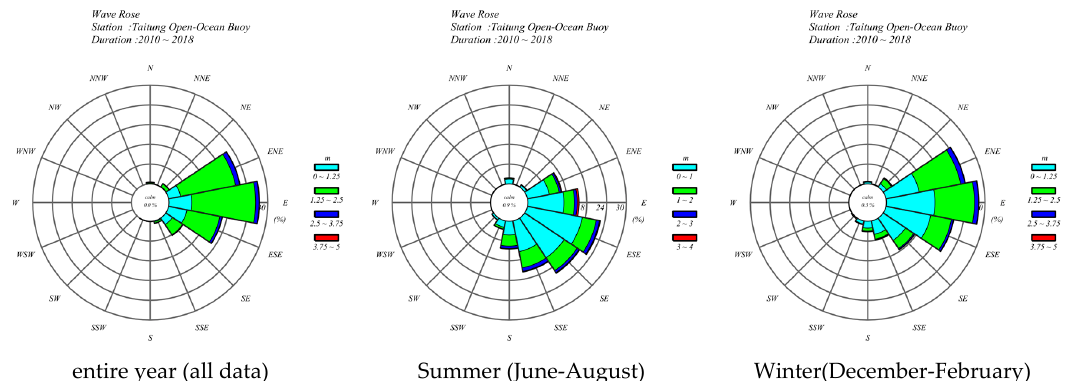
Figure 17. Wave rose diagrams for the entire year, the summer and winter of Taitung Open-Ocean Buoy.